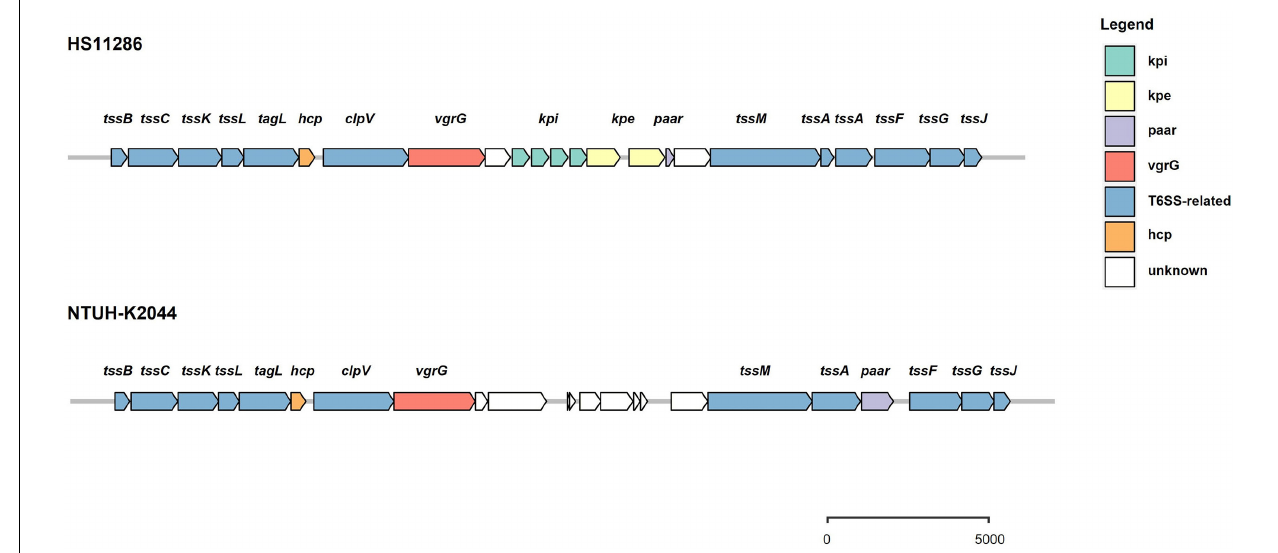
FIGURE 2 | Schematic representation of intact T6SS loci in K. pneumoniae . There are two arrangements of gene structure. One is represented by strain HS11286 and features the vgrG gene followed by genes encoding several immunity proteins and their cognate effectors, and then the paar gene. Another form is represented by strain NTUH-K2044 and features the vgrG gene followed by unknown variable regions, the tssM and tssA genes, and then the paar